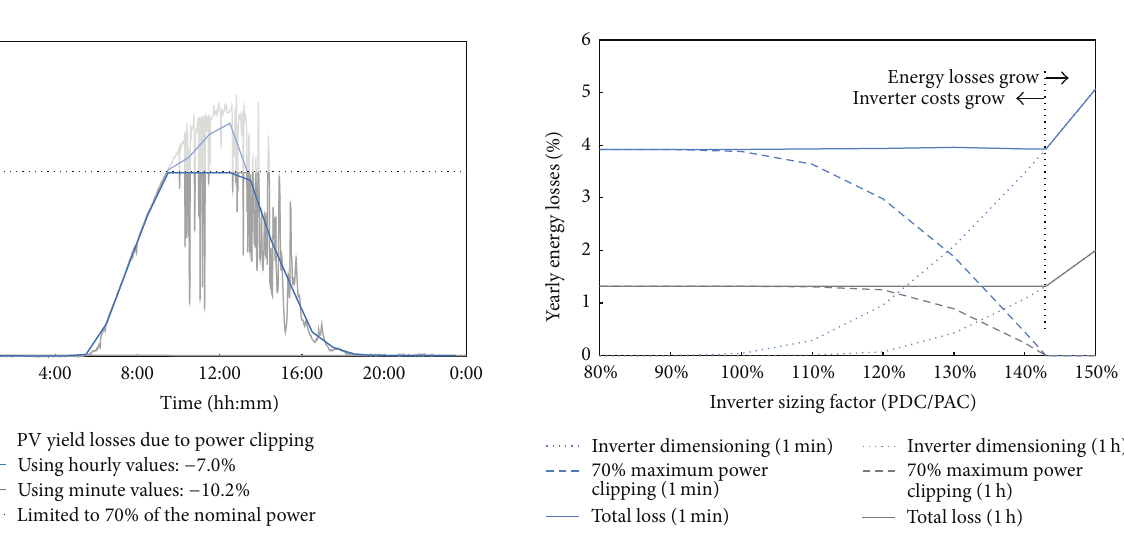
Figure 2: Yearly energy yield losses of a 1kWp PV system at HTW Berlin, Germany, for various inverter sizing factors (the relation between installed PV power on the DC side and nominal AC inverter output) and a maximum power clipping value of 70% (output power is cut at 70% of the installed DC power). Using hourly averaged values for the simulation of PV systems leads to a significant underestimation of the yearly yield losses. With hourly averaged values (grey), the total energy loss is at 1.3% while the more precise simulation with one-minute values (blue) returns a total energy loss of 3.9%. In addition, this figure illustrates that the optimal inverter sizing factor (here, 143%) for systems with maximum power clipping is the reciprocal of the clipping value